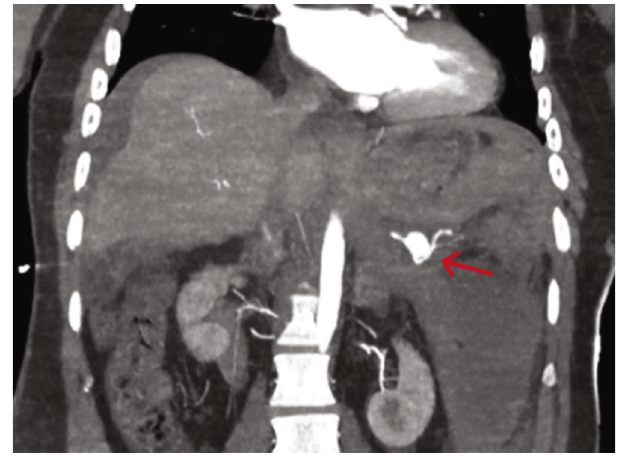
Figure 1: Large volume hemoperitoneum with active contrast extravasation from splenic artery on abdominal CT angiogram.